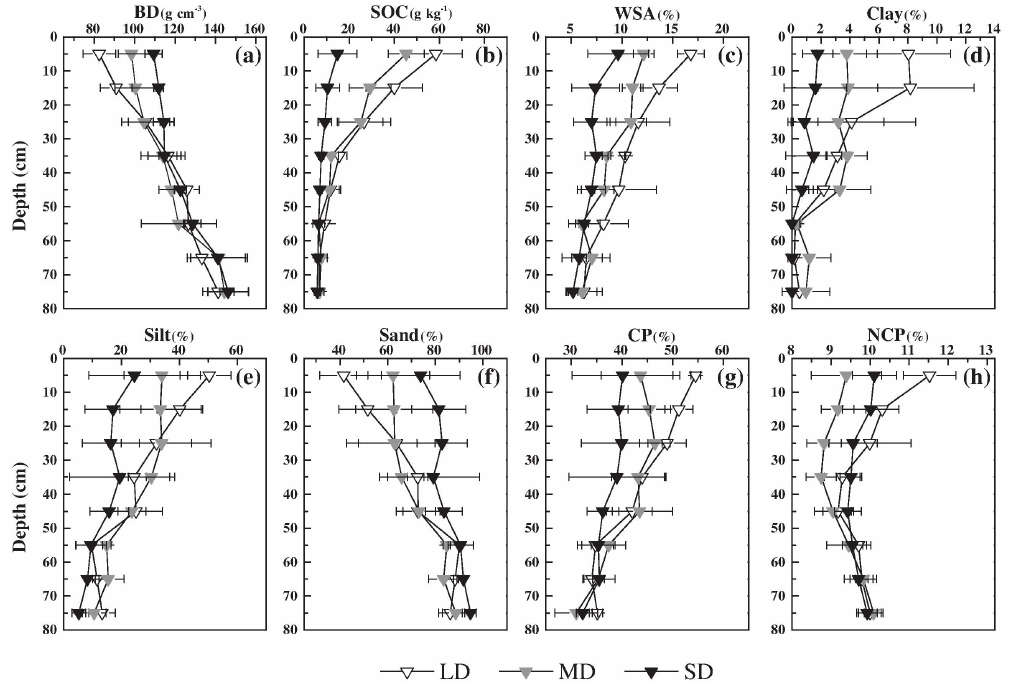
Figure 3. Basic soil properties of different degradation degrees. The error bars denote the standard deviation of the three sites of the same degradation degree. LD: lightly degraded, MD: moderately degraded, SD: severely degraded.